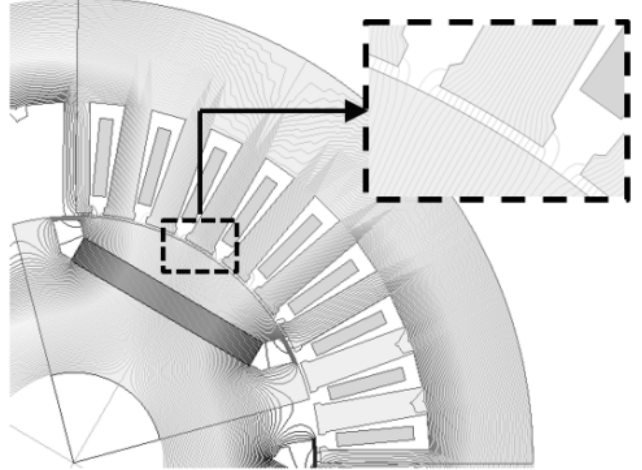
Figure 4. Flux line distribution by permanent magnets with slots.